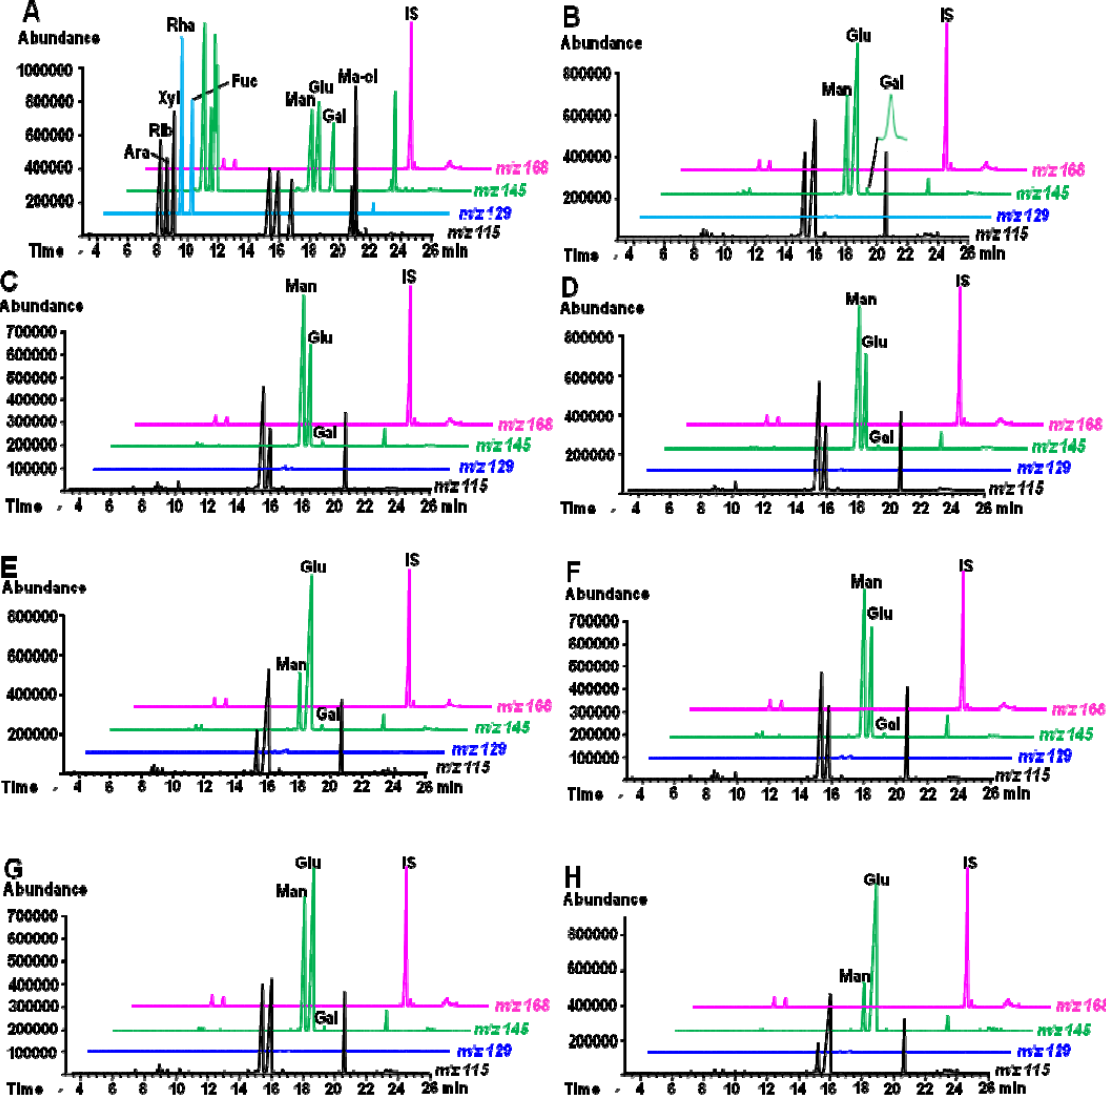
Figure 3. Typical SIM chromatograms of ( A ) mixed standards, and polysaccharides of Dendrobium officinale from ( B ) Yunnan, ( C ) Anhui, ( D ) Zhejiang, ( E ) D. fimbriatum from Yunnan, ( F ) D. huoshanense from Anhui, ( G ) D. nobile and ( H ) D. chrysotoxum from